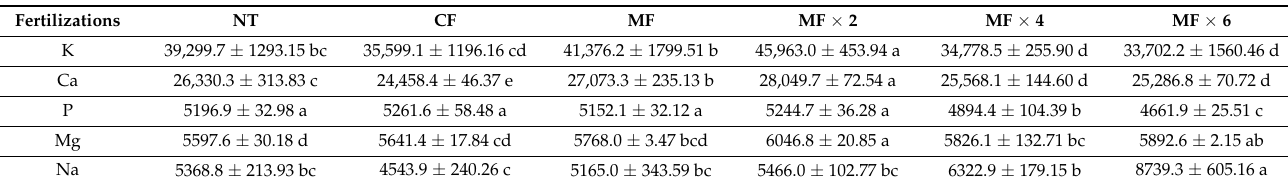
Figure 1. Endogenous abscisic acid quantification in Chinese cabbage. Each data point is the mean of at least three replicates. Error bars represent standard errors. The bars presented with different letters are significantly different from each other as evaluated by DMRT. Table 4. ICP analysis results for Chinese cabbage (ppm).